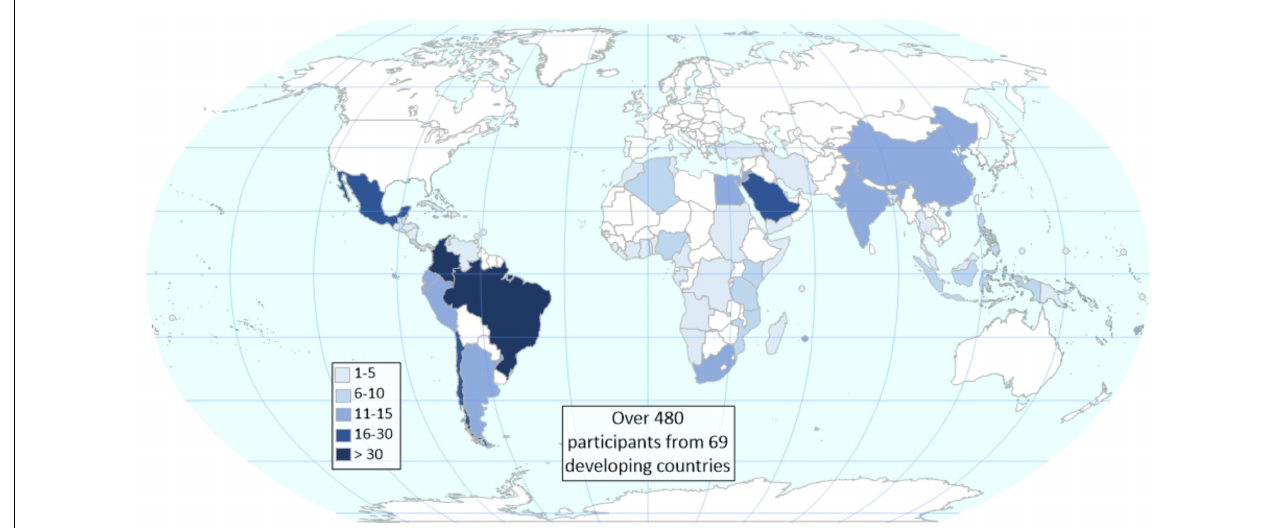
FIGURE 7 | Location and number of participants from developing countries involved in OA training workshops from 2012 to